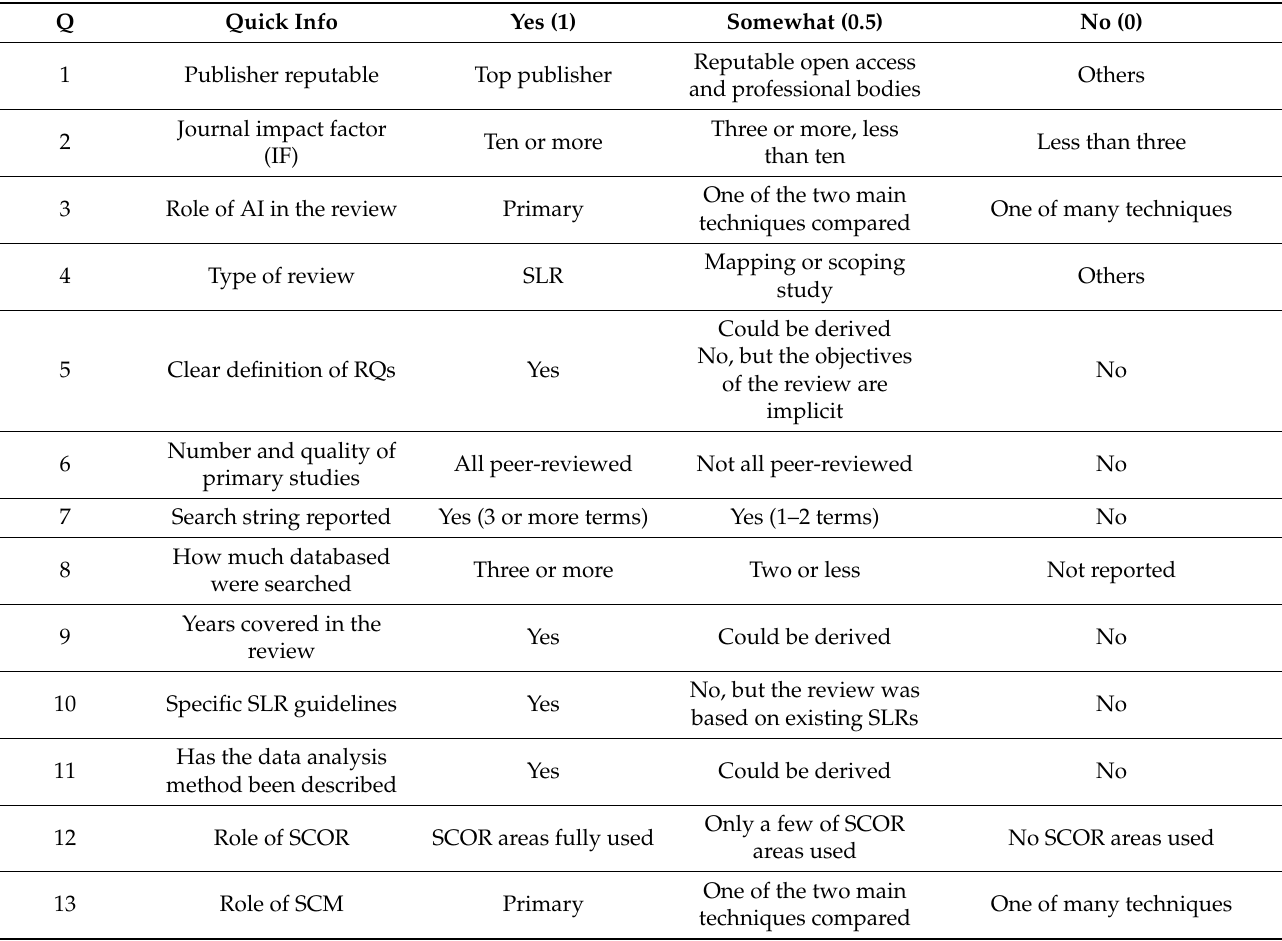
Table 6. Quality ranking